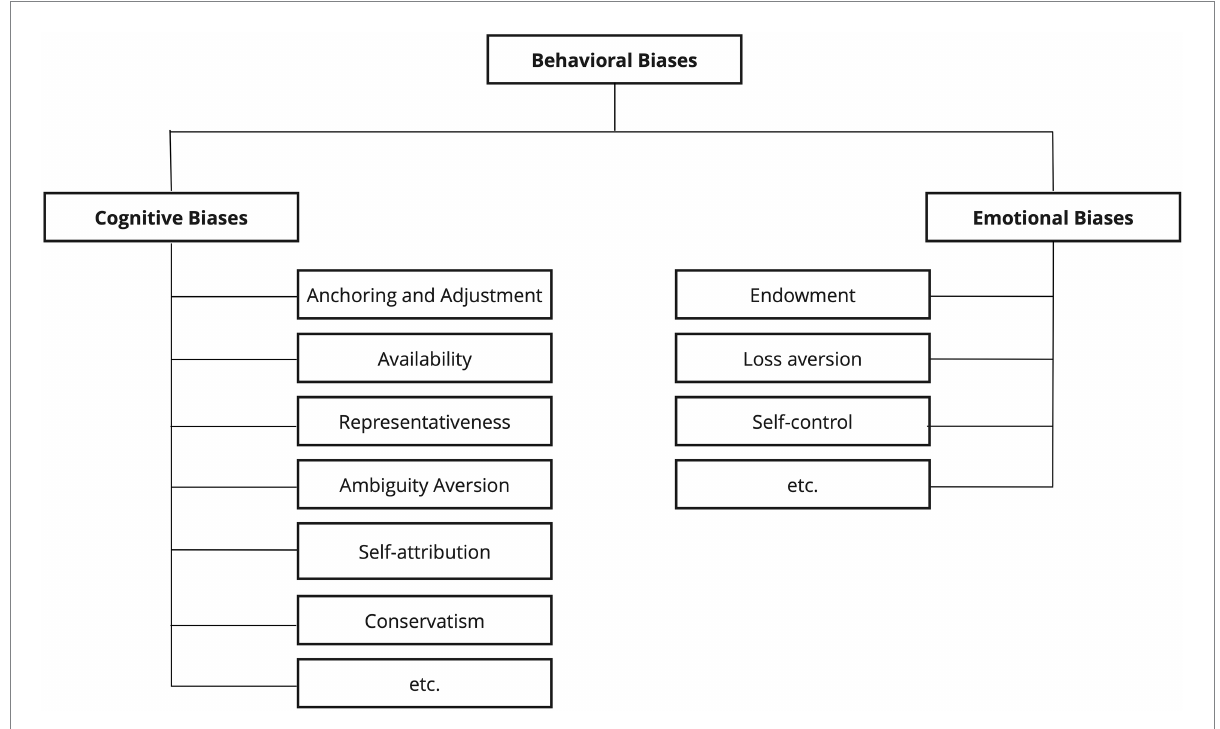
FIGURE 3 Example of behavioral biases’ taxonomy (Pompian,